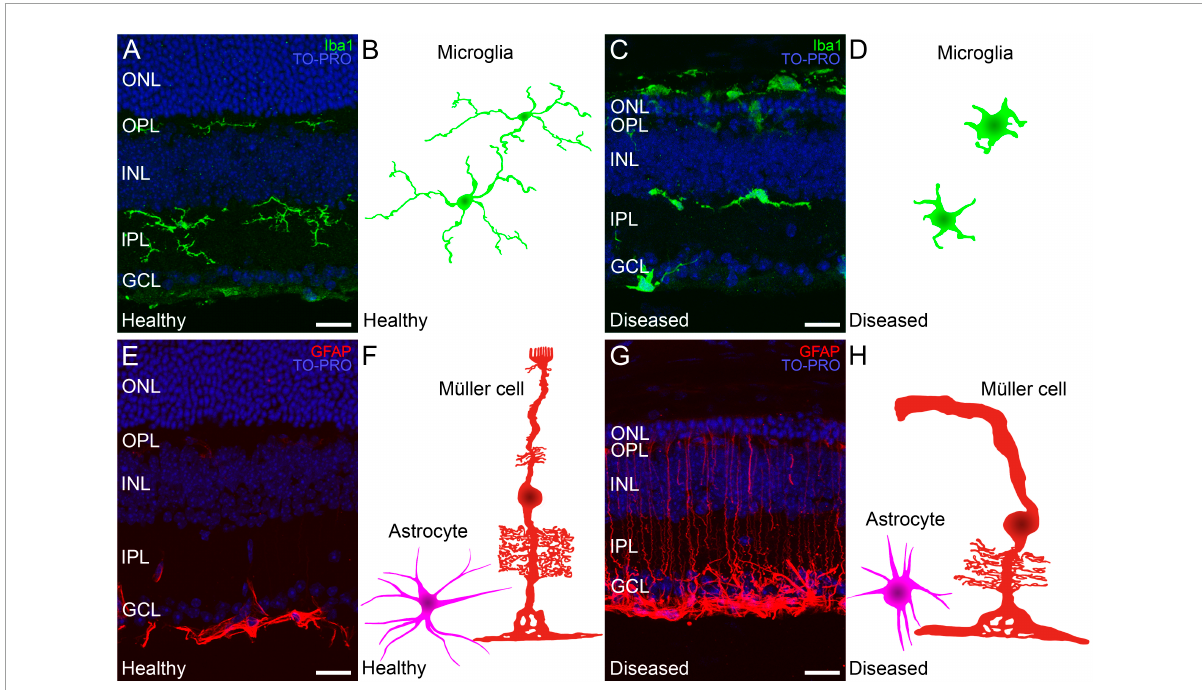
FIGURE6 Changes in Müller cells and microglia during retinal degeneration. Retinal cross-sections immunostained with different retinal glial cell markers followed by a schematic drawing of each cell in a healthy mouse retina and in a retina from an IRD model. (A,C) Microglia immunostained against Iba1 (in green) and TO-PRO 3 iodide-stained nuclei (in blue). (A) In healthy retinas microglial morphology is ramified and cells are localized in the IPL, OPL and GCL. (C) Ameboid morphology from active microglia in a retina with an IRD. (B,D) Schematic depiction of the morphology of microglial cells in healthy (B) and diseased conditions (D) . (E) In healthy retinas GFAP (red) marker selectively immunostains astrocytes in the GCL. (G) In IRDs, astrocytes display a hypertrophied morphology and Müller cell activation causes increased GFAP immunoreactivity throughout the cell length. (F,H) Schematic depictions of representative Müller cells and astrocytes in healthy conditions (F) and affected by retinal degeneration (H) . ONL: outer nuclear layer; OPL: outer plexiform layer; INL: inner nuclear layer; IPL: inner plexiform layer; GCL: ganglion cell layer. Scale bars: 20 µ